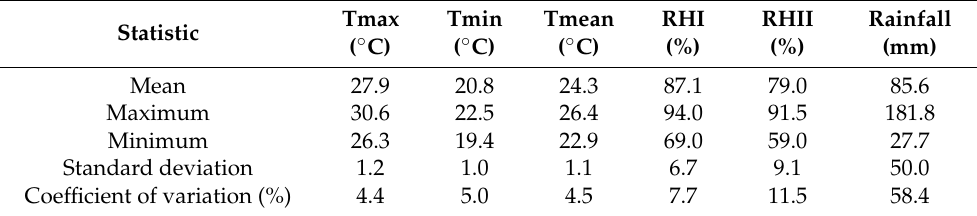
Table 9. Statistics of weather variables observed during the crop growth period.